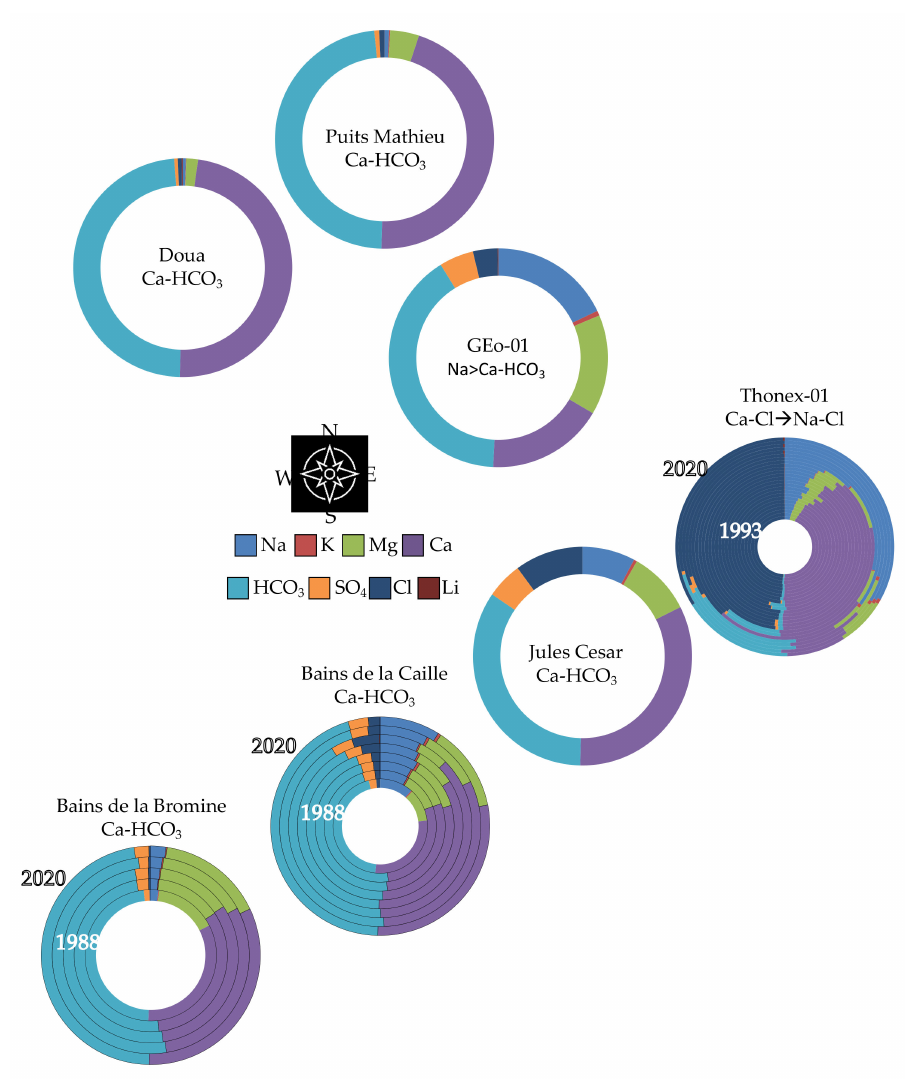
Figure 5. Schematic representation of the geographical and temporal (where available) distributions of the geochemical composition in major ions at the different analyzed